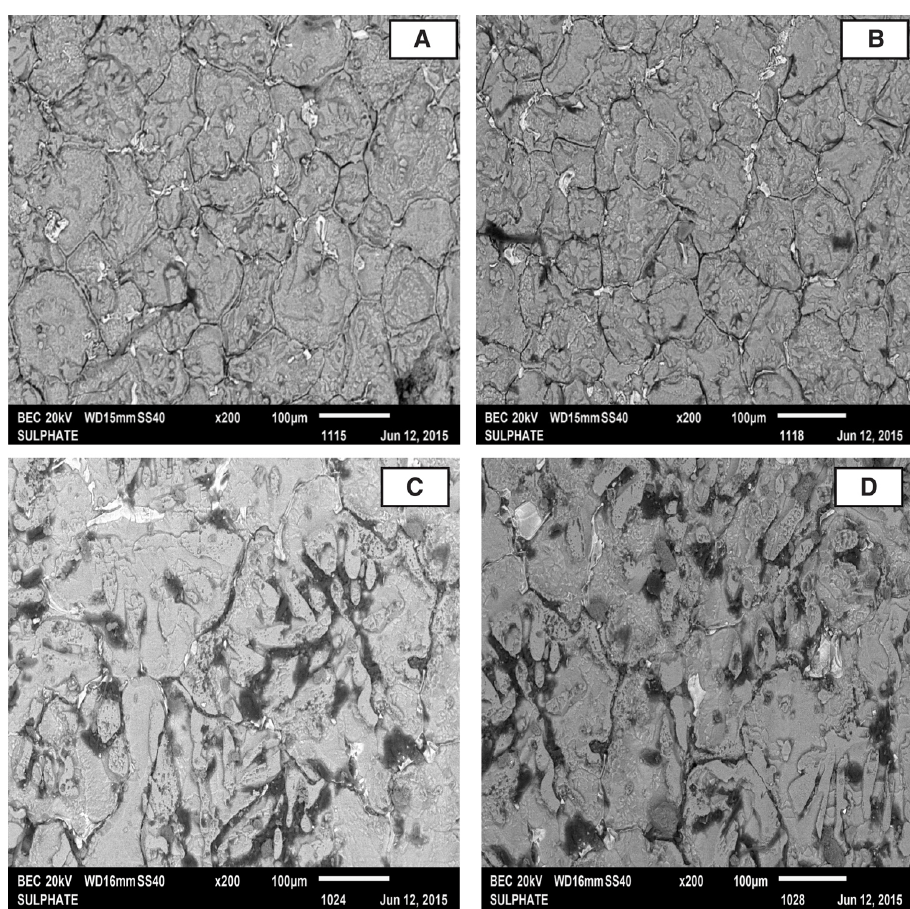
Figure 3: As-sintered NiTi alloy at (A) 3% binder percentage; (B) 6% binder percentage; (C) 9% binder percentage; (D) 15% binder percentage.